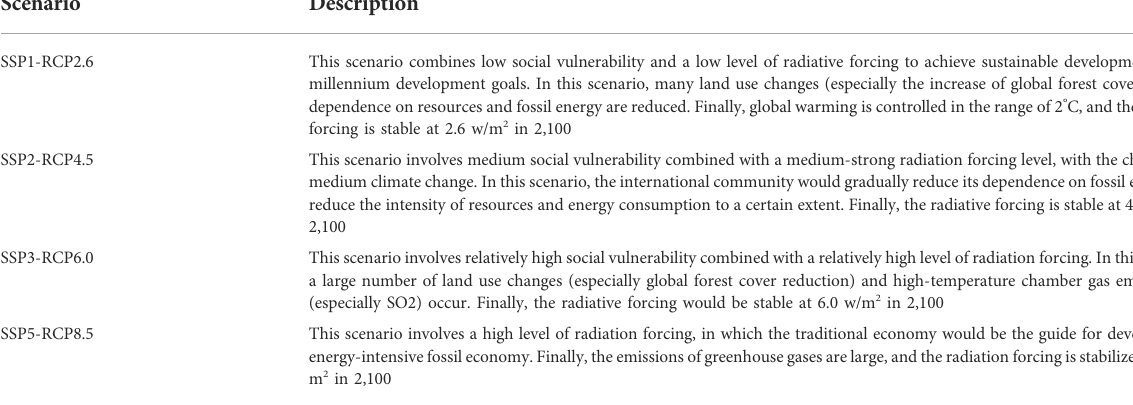
TABLE 3 Presentation of the four